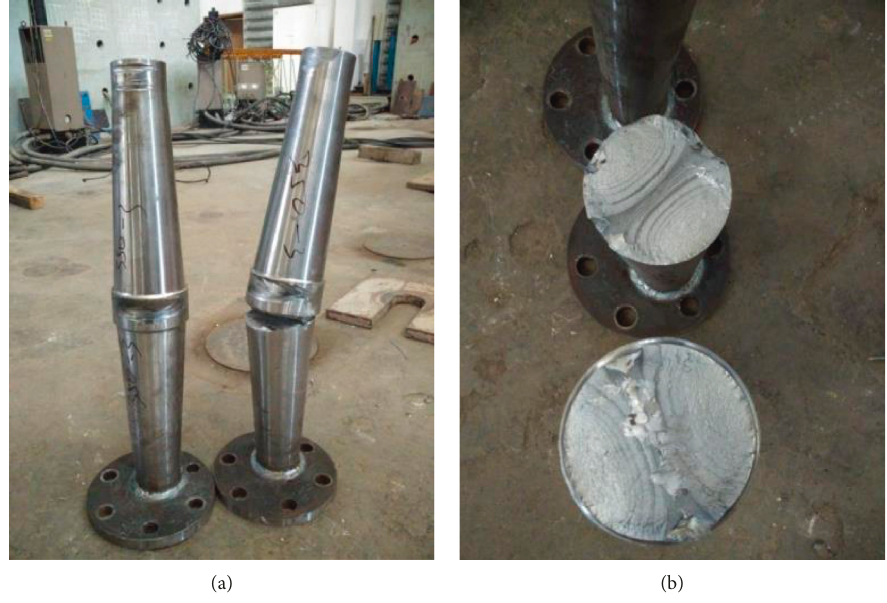
Figure 10: Failure form of specimen 350-3.